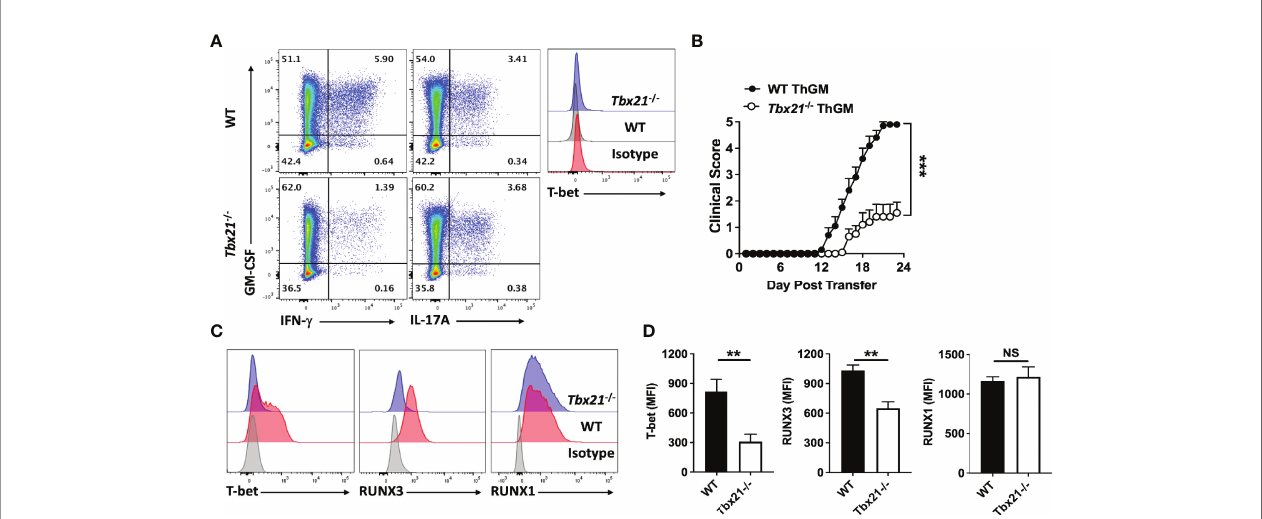
FIGURE 2 | ThGM cells upregulate RUNX3 in the CNS of mice with adoptive EAE in a T-bet-dependent manner. WT and Tbx21 -/- 2D2 naïve CD4 + T cells were differentiated into ThGM cells and transferred into Rag1 -/- mice (n = 10 mice/group). (A) Representative fl ow cytometry dot plots showing GM-CSF, IFN- g , IL-17A, and T-bet expression by WT and Tbx21 -/- ThGM cells before adoptive transfer. (B) Clinical severity score of Rag1 -/- mice with adoptive EAE. (C) Representative histogram of T-bet, RUNX3, and RUNX1 expression by WT and Tbx21 -/- ThGM cells from the CNS of Rag1 -/- mice with adoptive EAE. (D) MFI for T-bet, RUNX1, and RUNX3 in WT and Tbx21 -/- ThGM cells from the CNS of Rag1 -/- mice with adoptive EAE. Data shown are mean ± SEM. For EAE, p-values were calculated using two-way ANOVA with Bonferroni ’ s multiple comparison correction. Parametric datasets were analyzed using unpaired Student ’ s t-test with Bonferroni ’ s correction; **p < 0.01, ***p < 0.001, NS, not signi fi